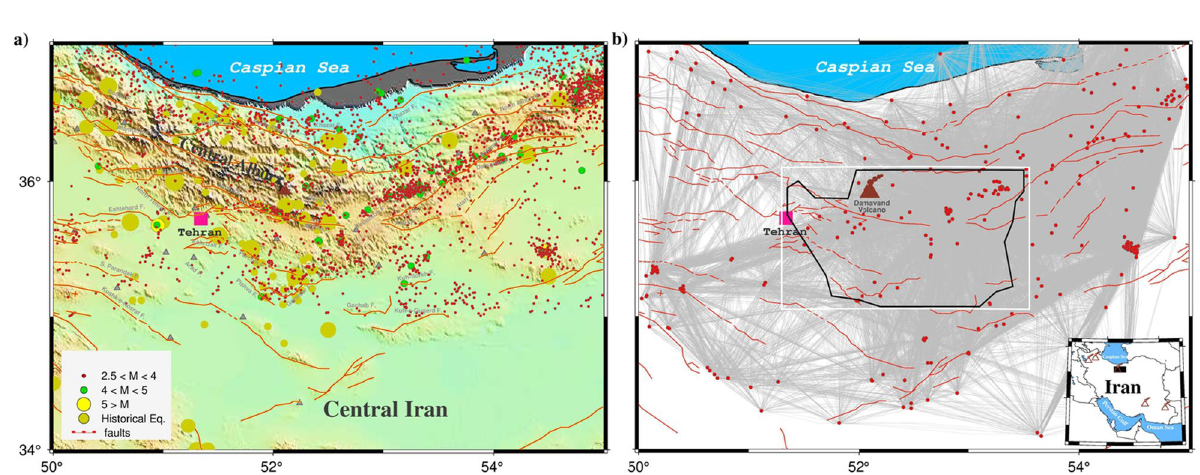
Figure 2. The map of the study area. The know faults, circles and volcano depict by solid red lines, earthquakes and brown triangle, respectively. The pink square represent Tehran, capital of Iran. The historical events reported by 11–14 and instrumental earthquakes in the central Aborz located by Ir anian S eismological C enter, IrSC (http:// irsc. ut. ac. ir). The white box shows a region with a fair resolution (Figs. 2–6). The black rectangular in the inset map indicates the study area. This figure has depicted by Generic Mapping Tools (GMT) version 6.2.0 ( 31